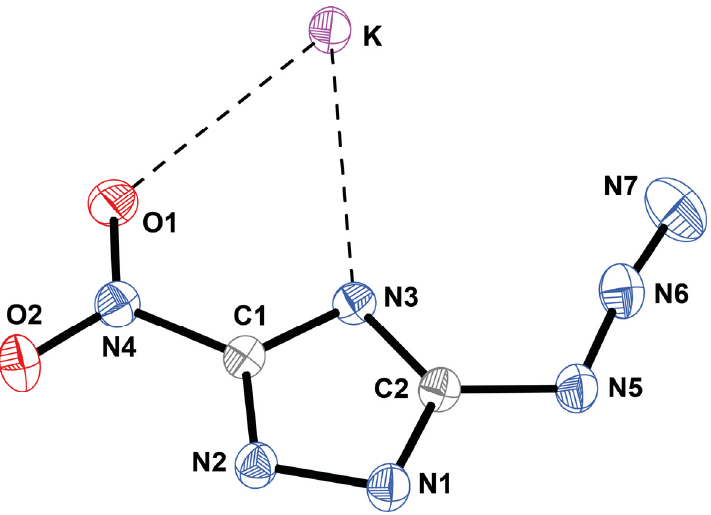
Figure 6. Molecular structure of potassium 5-azido-3-nitro-1,2,4-triazolate ( 3